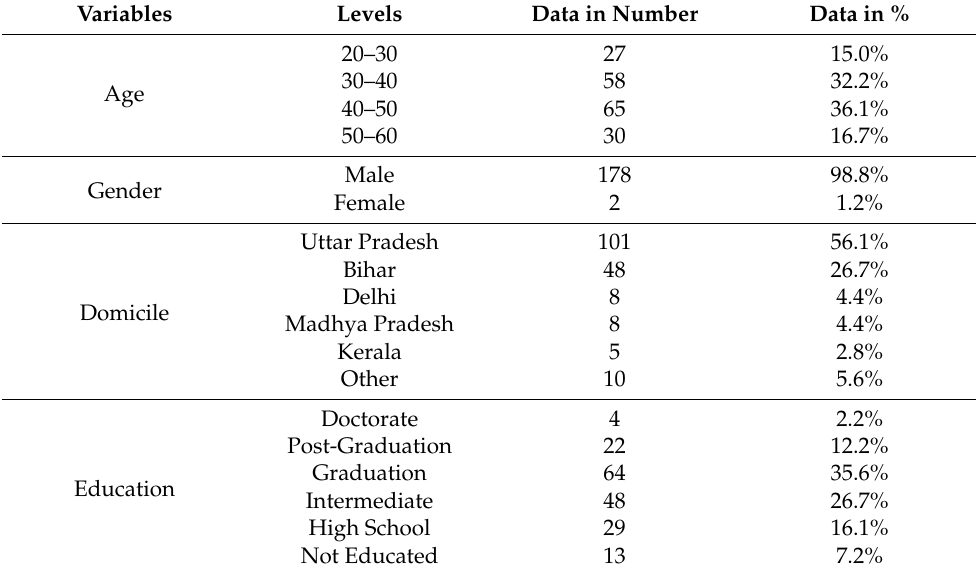
Table 1. Demographic Profile of the